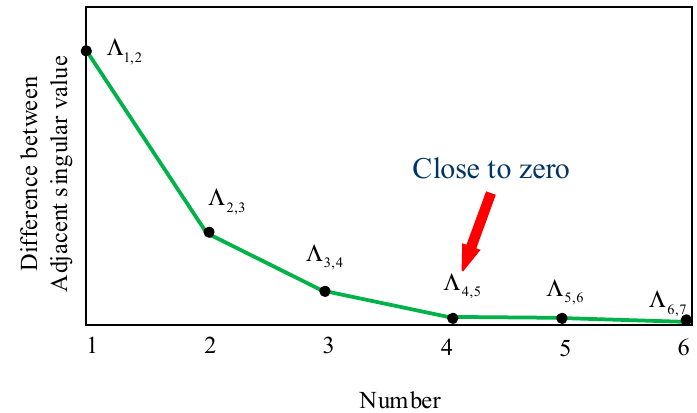
Figure 3. The schematic diagram of the adaptive estimation of the number of modes.